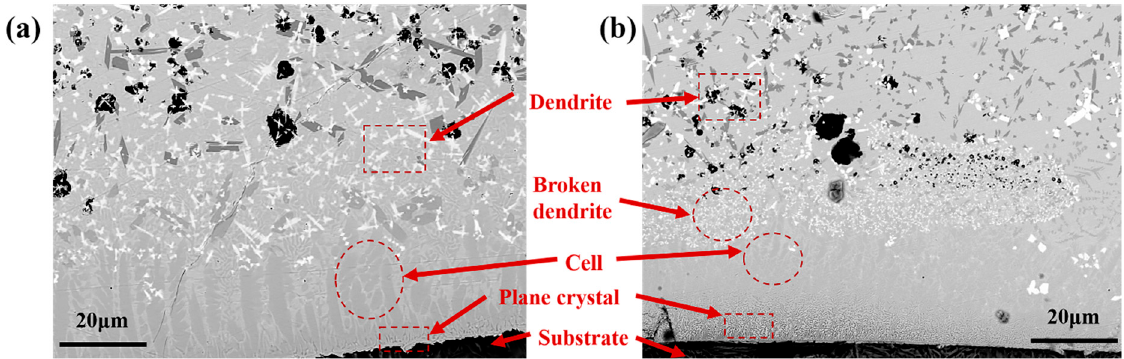
Figure 13. Microstructures of the junction between the cladding layer bottom and the substrate ( a ) without ultrasonic vibrations and ( b ) with ultrasonic vibrations (UP = 800 W, F = 32